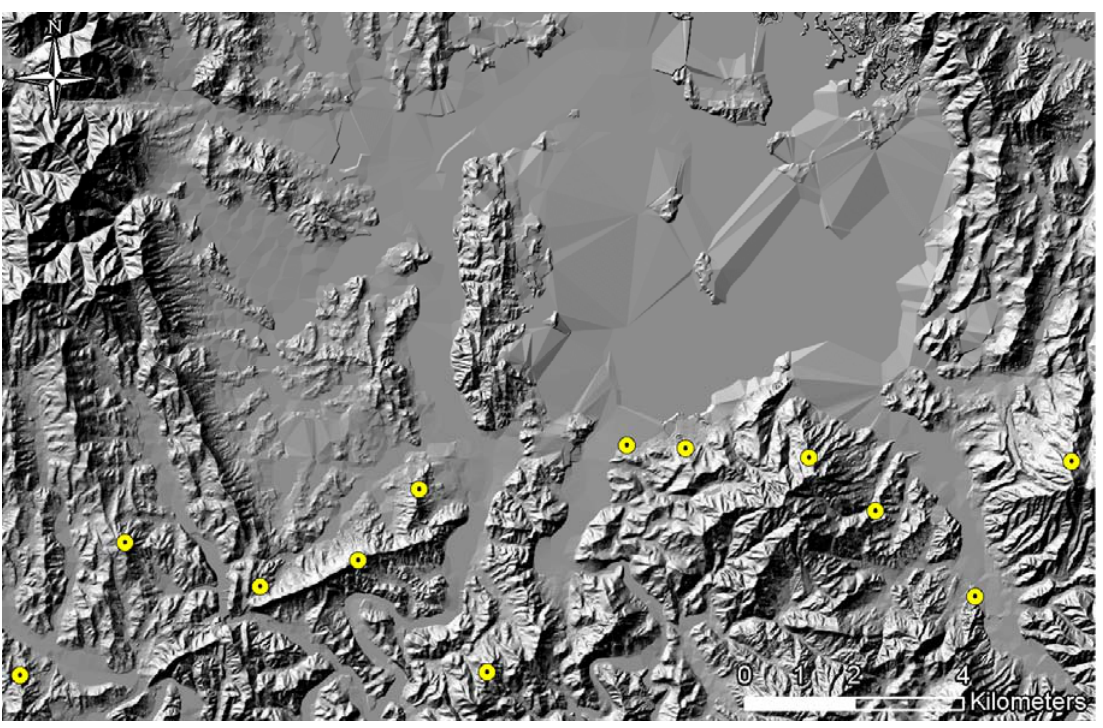
Figure 5. Locations of TODs.